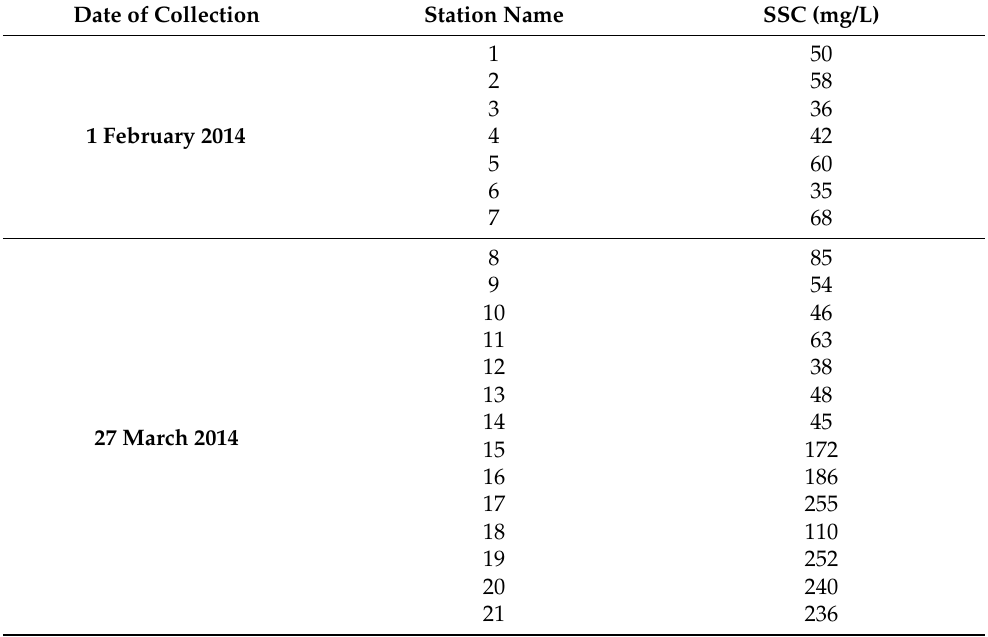
Table 2. Observed SSC by Pitchaikani et al. [62] for the Bhagirathi-Hugli River estuary (Stations 1–24) spanning 21 ◦ 37 (cid:48) 8.15 (cid:48)(cid:48) N to 21 ◦ 52 (cid:48) 50.93 (cid:48)(cid:48) N; 87 ◦ 33 (cid:48) 25.03 (cid:48)(cid:48) E to 88 ◦ 9 (cid:48) 36.42 (cid:48)(cid:48)